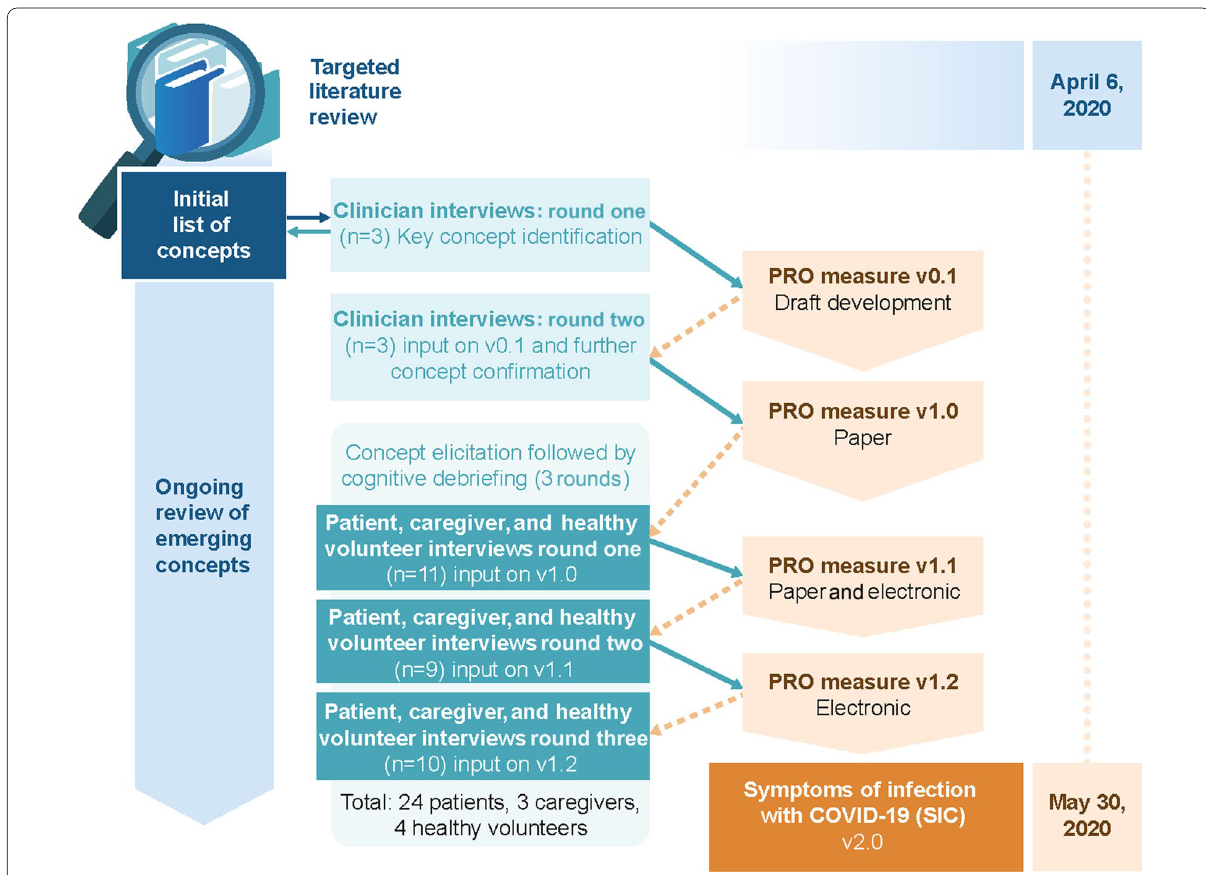
Fig. 1 Symptoms of infection with COVID-19 (SIC) development process. Abbreviations: COVID-19 coronavirus disease 2019, PRO patient-reported